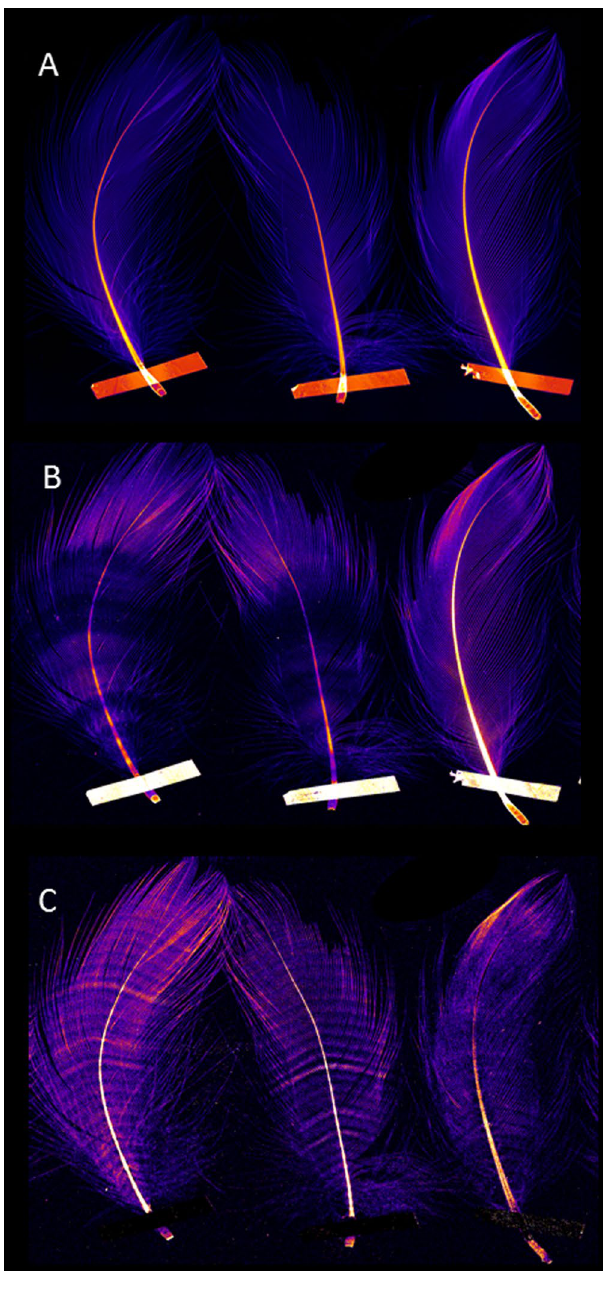
Figure 4. Compton ( A ) Br ( B ) and Zn ( C ) patterns Streaked Shearwater feathers ( Calonectris leucomelas ). Three breast feathers from three individual Streaked Shearwater, scanned simultaneously in high resolution, demonstrate the distinct banding of the Br distribution and regular patternation of Zn along the length of the rachis. Maps of Compton inelastic scattering were constructed from the XFM to inform the anatomy and composition of each sample. The intensity of Compton scatter is equivalent to the mass and density of material encountered by the incident beam and was used to correlate changes in elemental concentration and distribution with potential changes in the composition of each sample. The deposition pattern of the elements Br and Zn is independent of regional mass and density in the